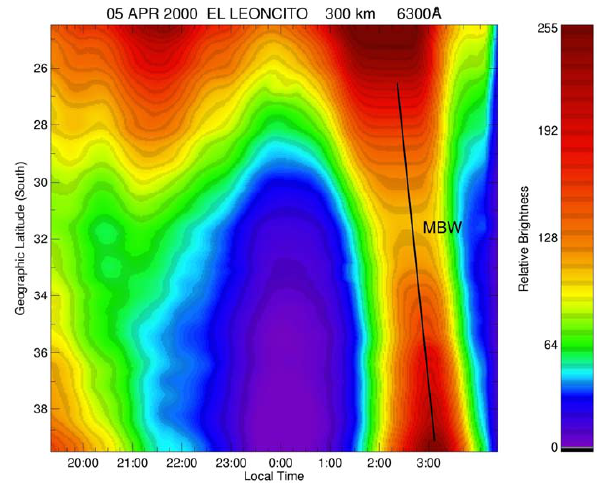
Figure 3. Fig. 3. A meridional intensity scan constructed from data taken by the El Leoncito imager on the evening of 5 April 2000. The MBW event is clearly evident in this scan. The MBW enters the field of view from the north at approximately 02:00 LT and exits to the south near 03:15 LT. The black line indicates a linear fit to the MBW’s poleward propagation